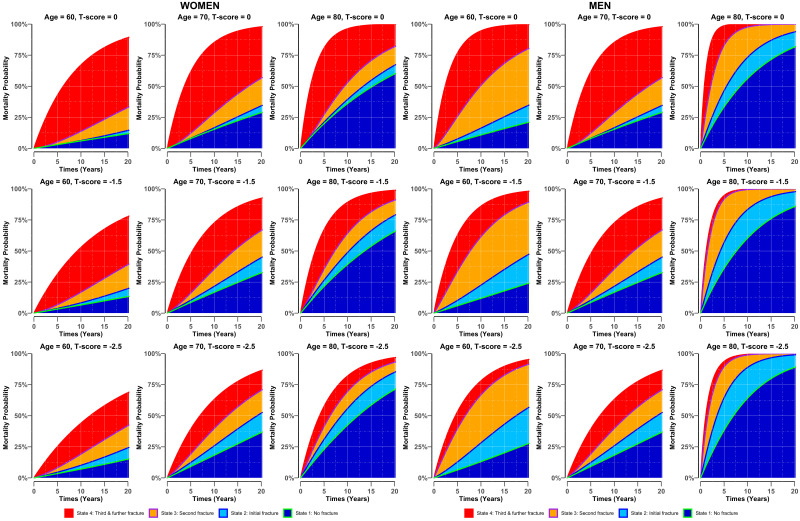
Adjusted cumulative mortality probability in women (left panel) and men (right panel) by bone health state.An individual could stay in a state (state 1 to state 4) before transiting to state 5 (i.e., mortality): state 1: no fracture (blue area) if an individual entered the study without any osteoporotic fracture; state 2: initial fracture (light blue area) if an individual had sustained a fracture after study entry; state 3: second fracture (orange area) if an individual had suffered a second fracture; and state 4: third and further fractures (red area) if an individual had suffered two or more subsequent fractures during the follow-up period. Risk was estimated for women and men with different BMD profiles (i.e., T-score = 0, –1.5, and −2.5), at different event ages (60, 70, and 80), with all other factors being at the sample mean, that is, body mass index = 26.6 kg/m2 (equal to mean), no history of fall at baseline, no prior fracture and no comorbidities.Figure 3—figure supplement 1—source data 1.Adjusted cumulative mortality probability in women and men by bone health state.Risk was estimated for women and men with different BMD profiles (i.e., T-score = 0, –1.5, and −2.5), at different event ages (60, 70, and 80), with all other factors being at the sample mean, that is, body massindex = 26.6 kg/m2 (equal to mean), no history of fall at baseline, no prior fracture and no comorbidities.